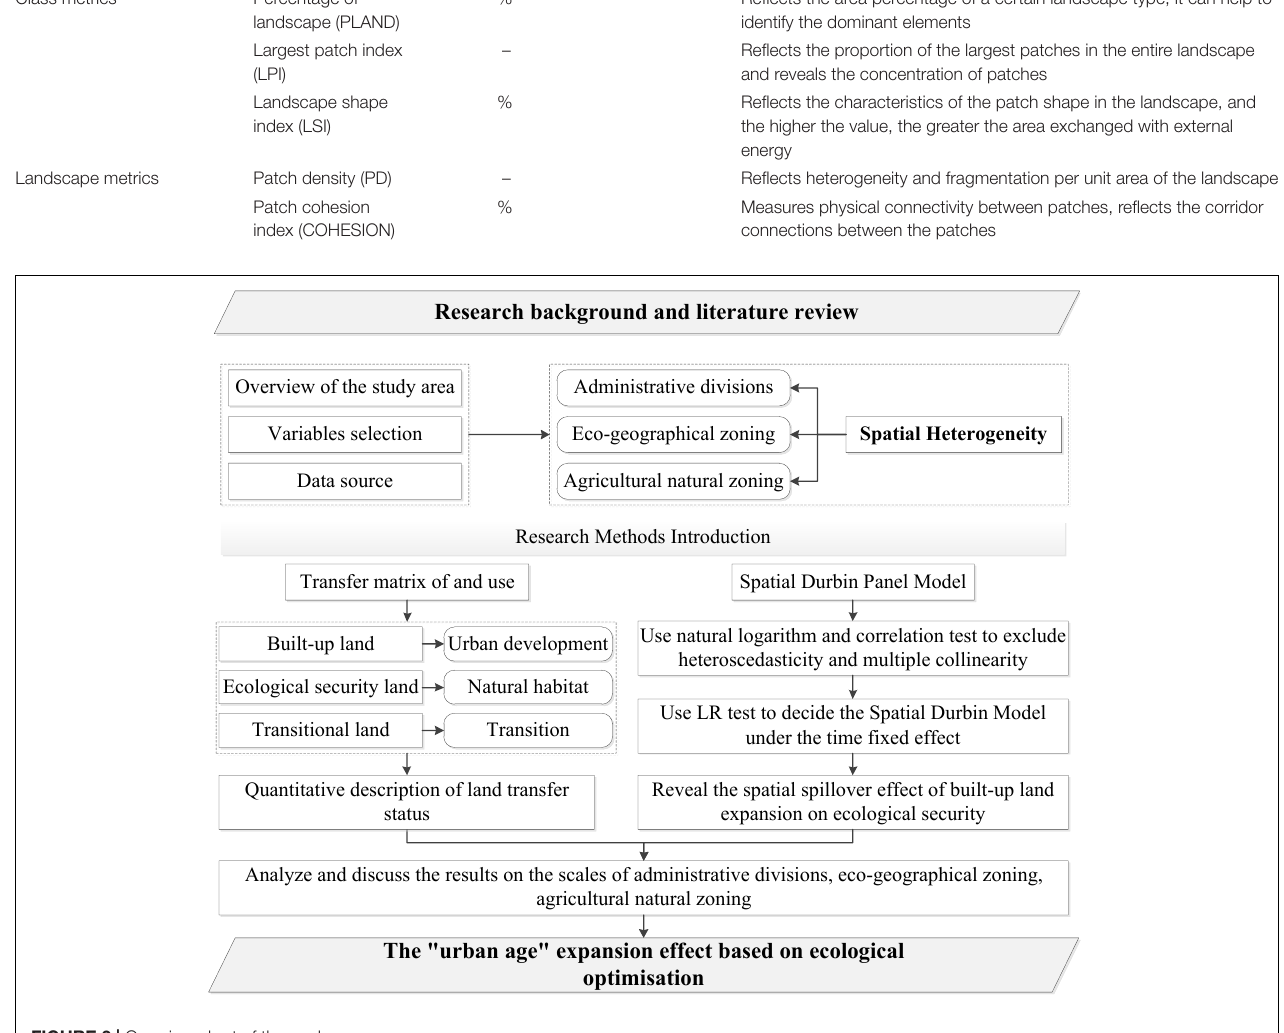
FIGURE 3 | Overview chart of the work progress.